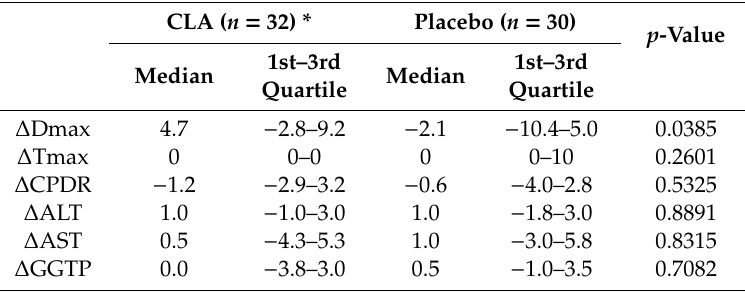
Table 4. E ff ects of conjugated linoleic acid (CLA) and placebo on liver outcome